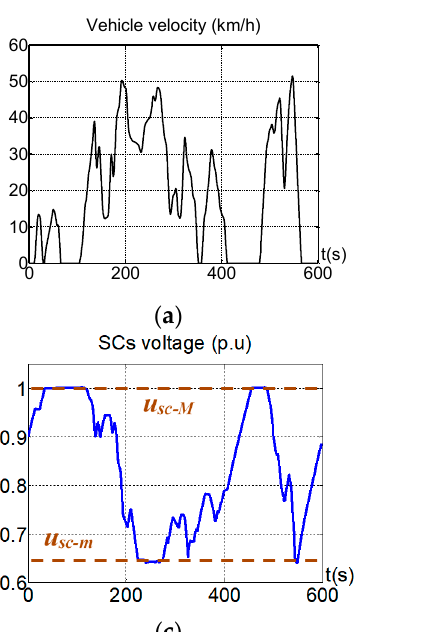
Figure 11. ( a ) WLTC class 2 low-speed phase. ( b ) Fuel cell currents i Lfc for the fuel cell–battery–super capacitor (FC-BAT-SC)-based vehicle (black line) and fuel cell (FC)-based vehicle without any secondary source (green line). ( c ) Voltage of the super capacitors u sc . ( d ) State of charge of the battery SoC b .